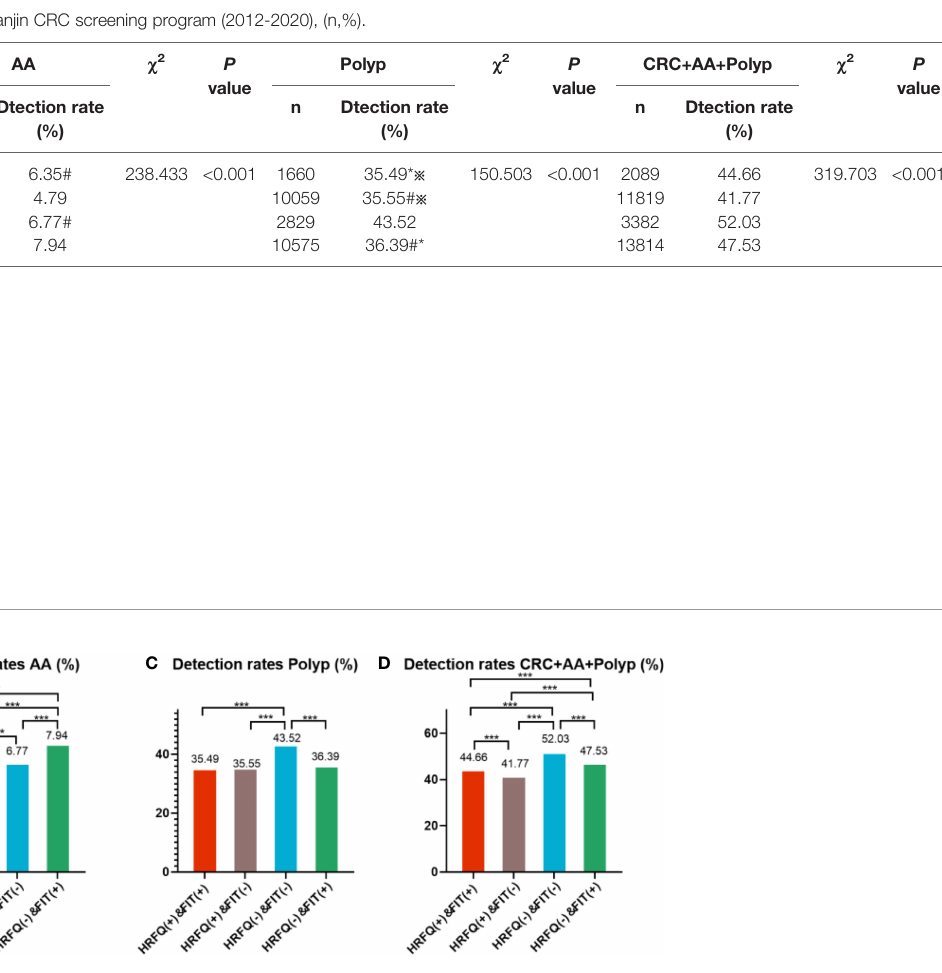
FIGURE 7-2 | Comparison of colonoscopy results of CRC (A) , AA (B) , CRC+AA+polyp (C) and polyp (D) among different screening methods in Tianjin CRC screening program. ***There are signi fi cant differences in detection rates between the different screening